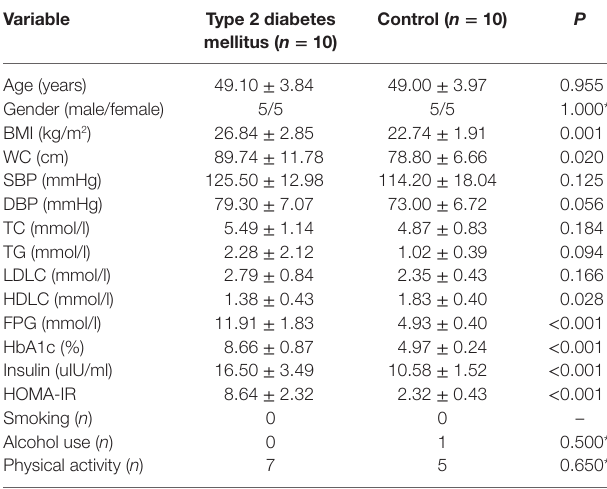
TaBle 1 | Demographic and clinical characteristics of participants in the microRNA profile